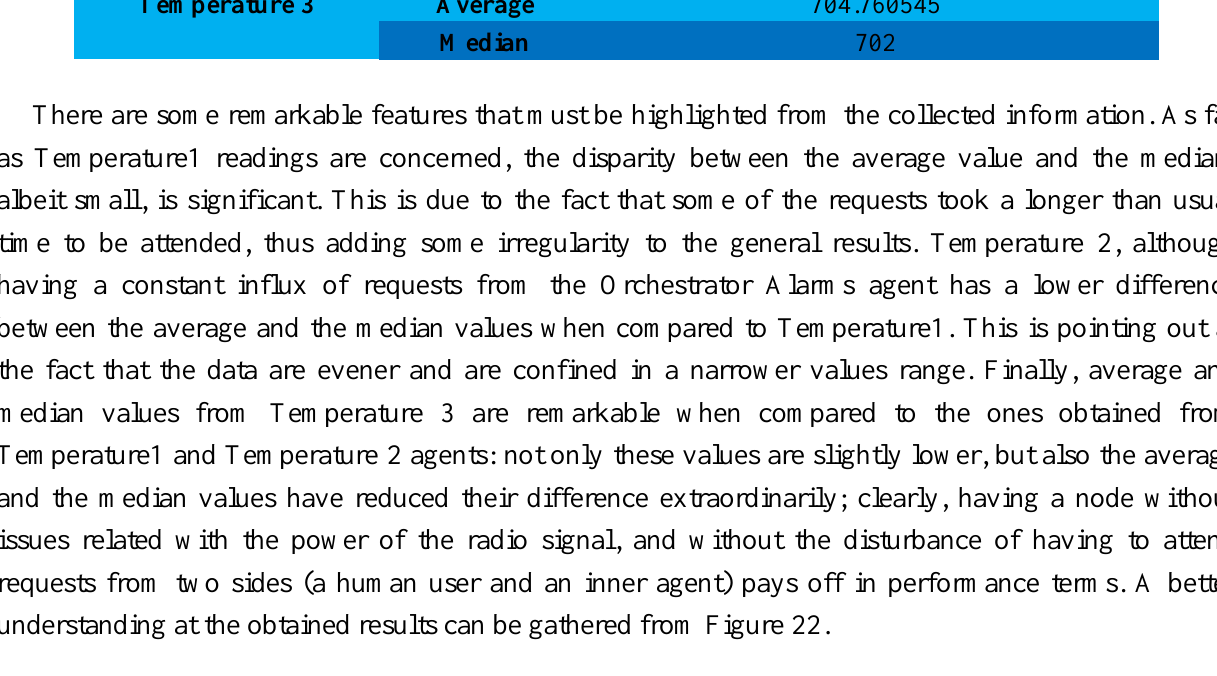
Figure 22. Time used to answer temperature